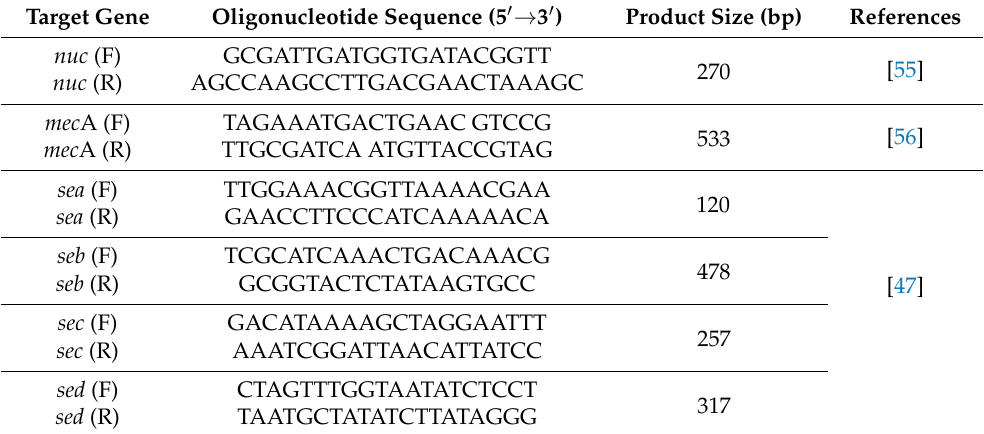
Table 8. Primer sequences of nuc , mec A, and enterotoxin gene for S. aureus detection used for PCR identification